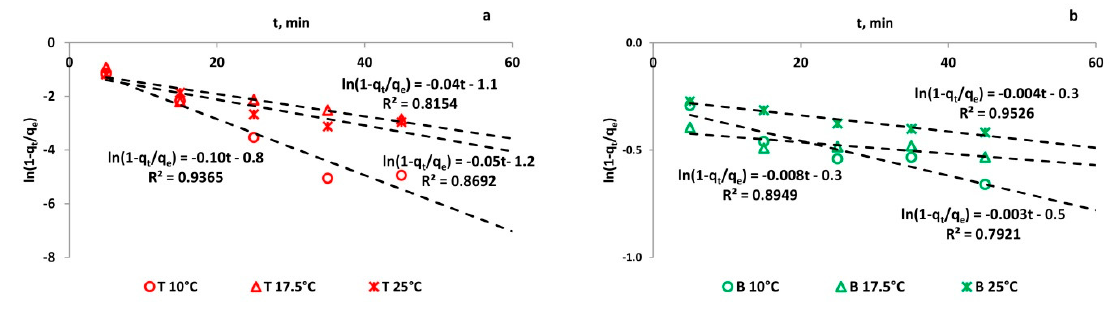
Figure 6. Liquid film diffusion kinetic plot for Mn sorption on: ( a ) tuff and ( b ) basalt.